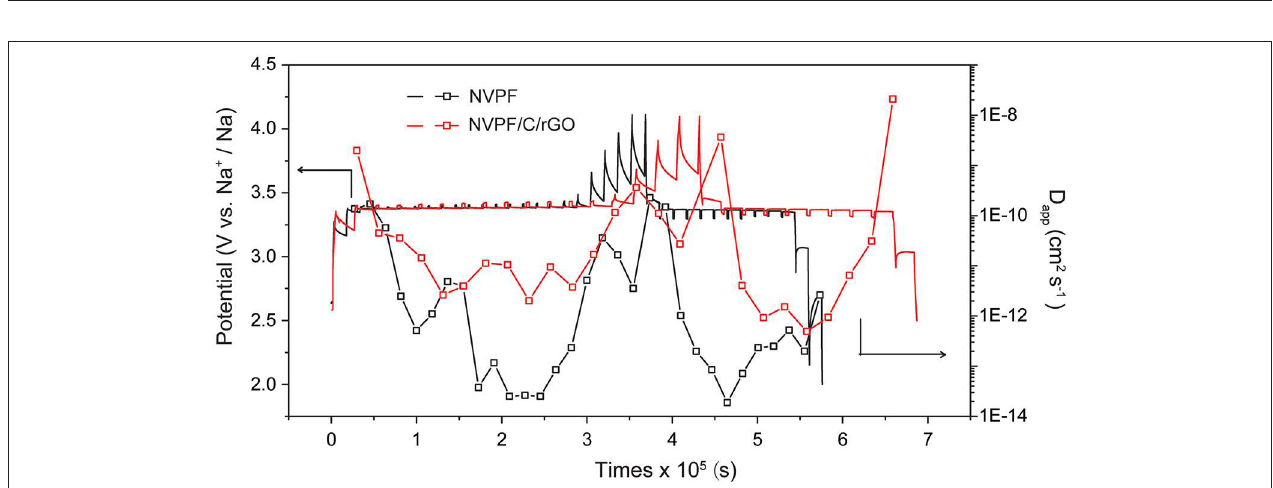
FIGURE 7 | GITT test results containing D app and variation curve along with the GCD processes of NVPF/C/rGO and NVPF.